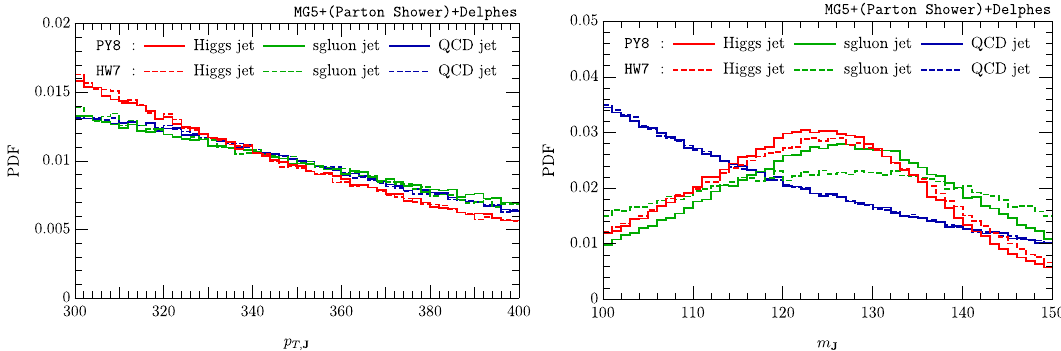
Figure 4 . The distribution of p T; J (left) and m J (right) of the leading jet. The red, green, and blue solid (dashed) lines correspond to the Higgs jet, sgluon jet, and QCD jet of PY8 ( HW7 ) samples,